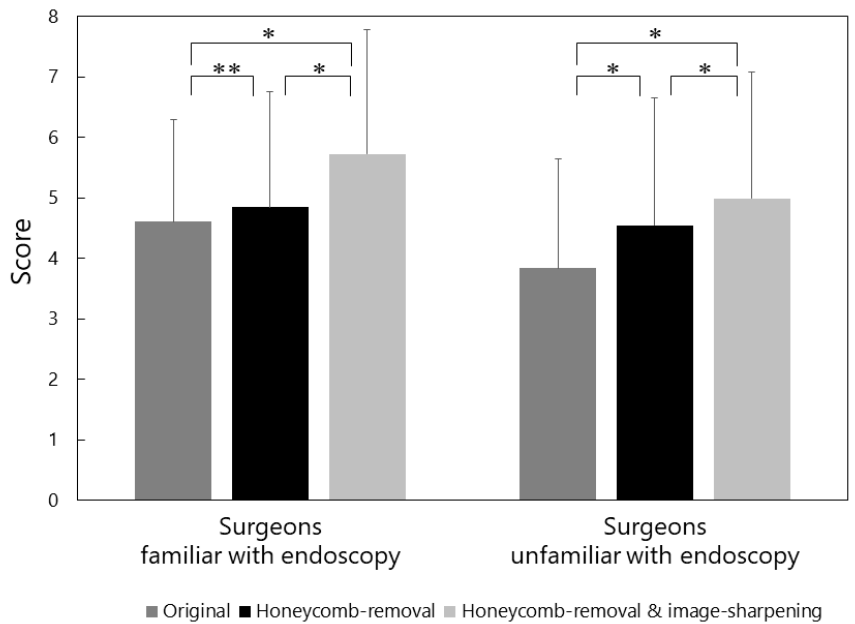
Figure 3. Visibility scores analysed separately for surgeons who were familiar with endoscopic vitrectomy ( n = 10) and those who were not ( n = 8). Implementation of image-processing algorithms significantly improved visibility of endoscopic vitrectomy (* p < 0.001, ** p = 0.076, linear mixed effects model).